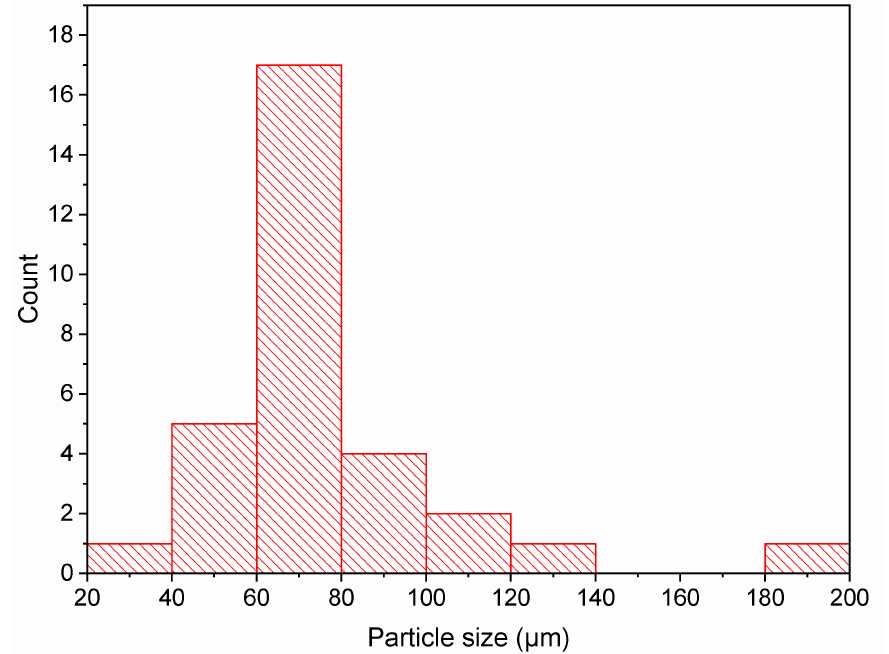
Figure 9. Particle size distribution.